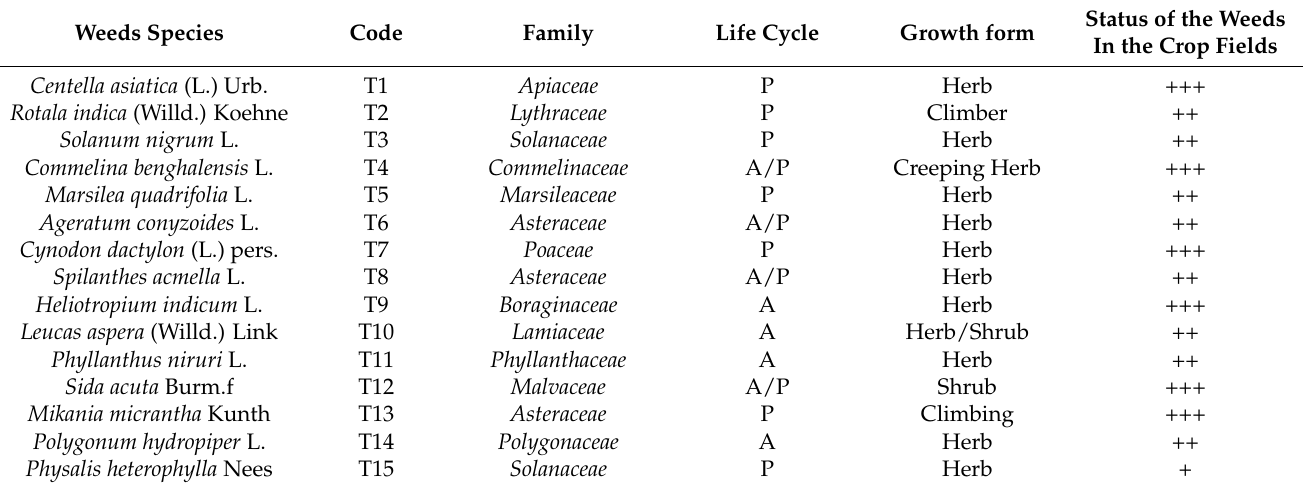
Table 1. Field status of weed species collected from the crop fields around the botanical garden of Chittagong University